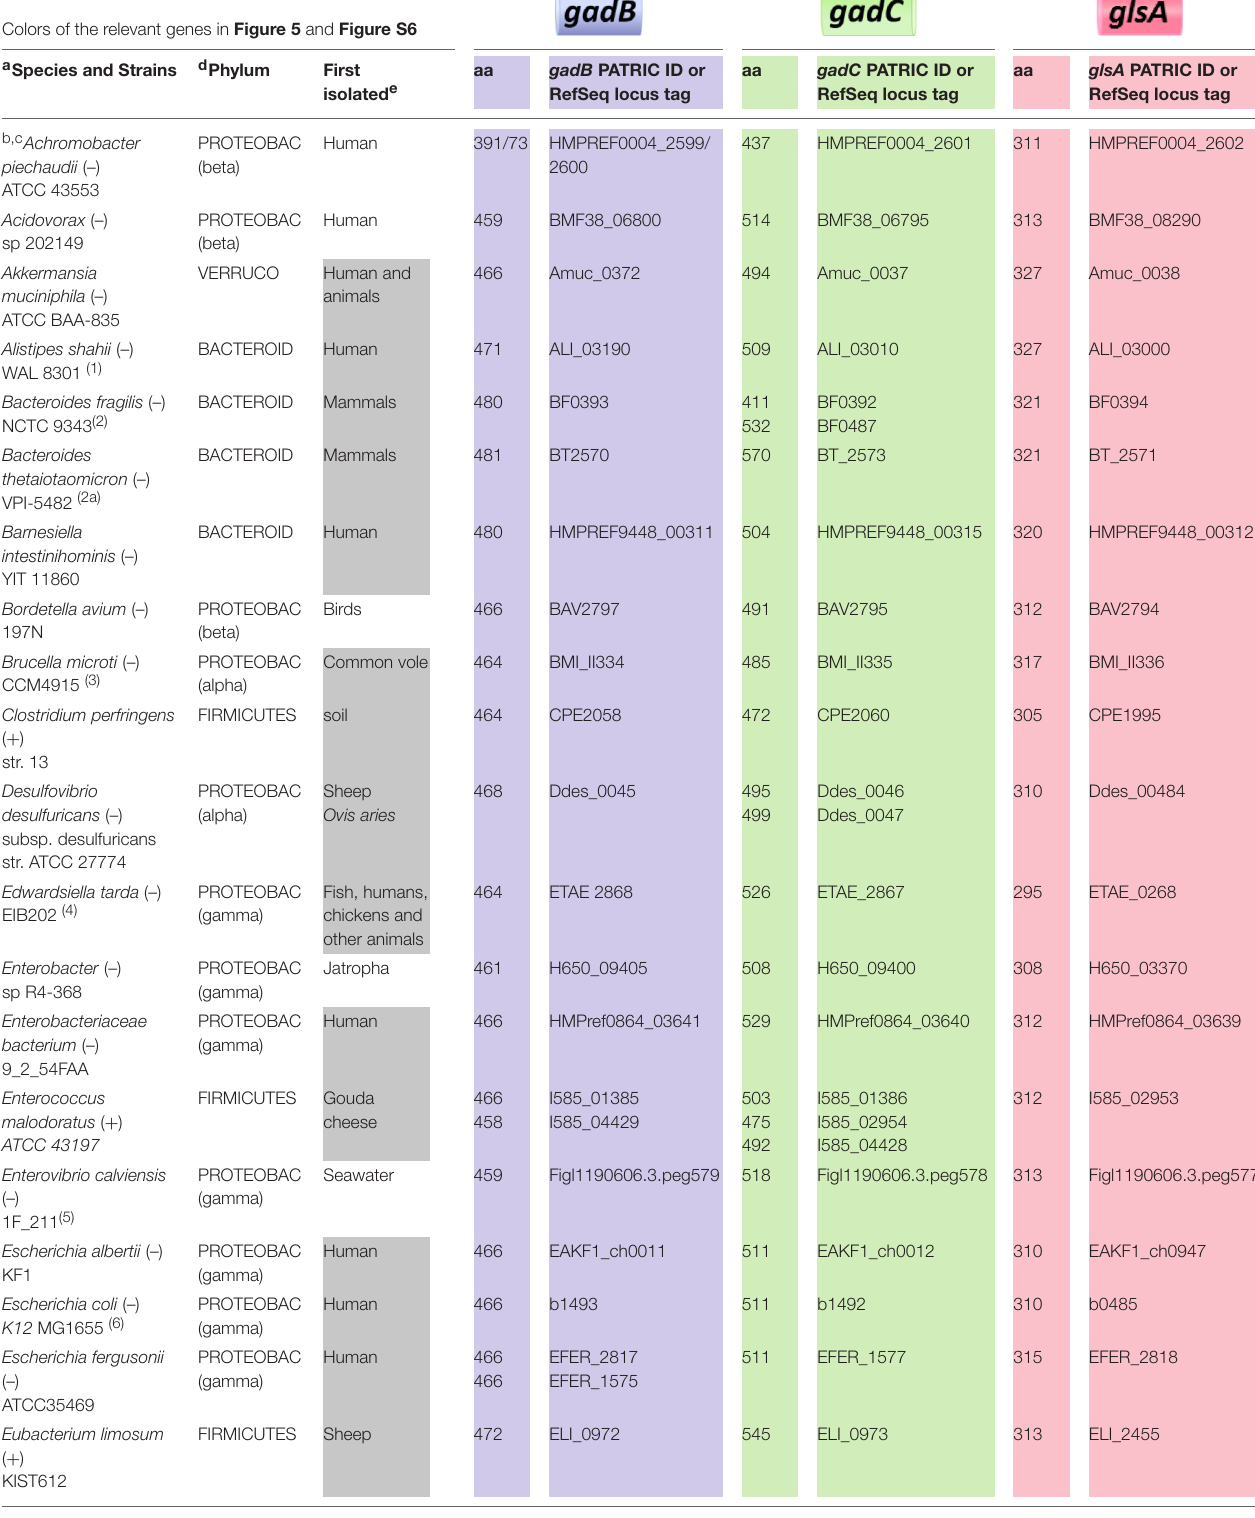
TABLE 1 | Bacteria species possessing a potentially functional glutamine-dependent AR system.